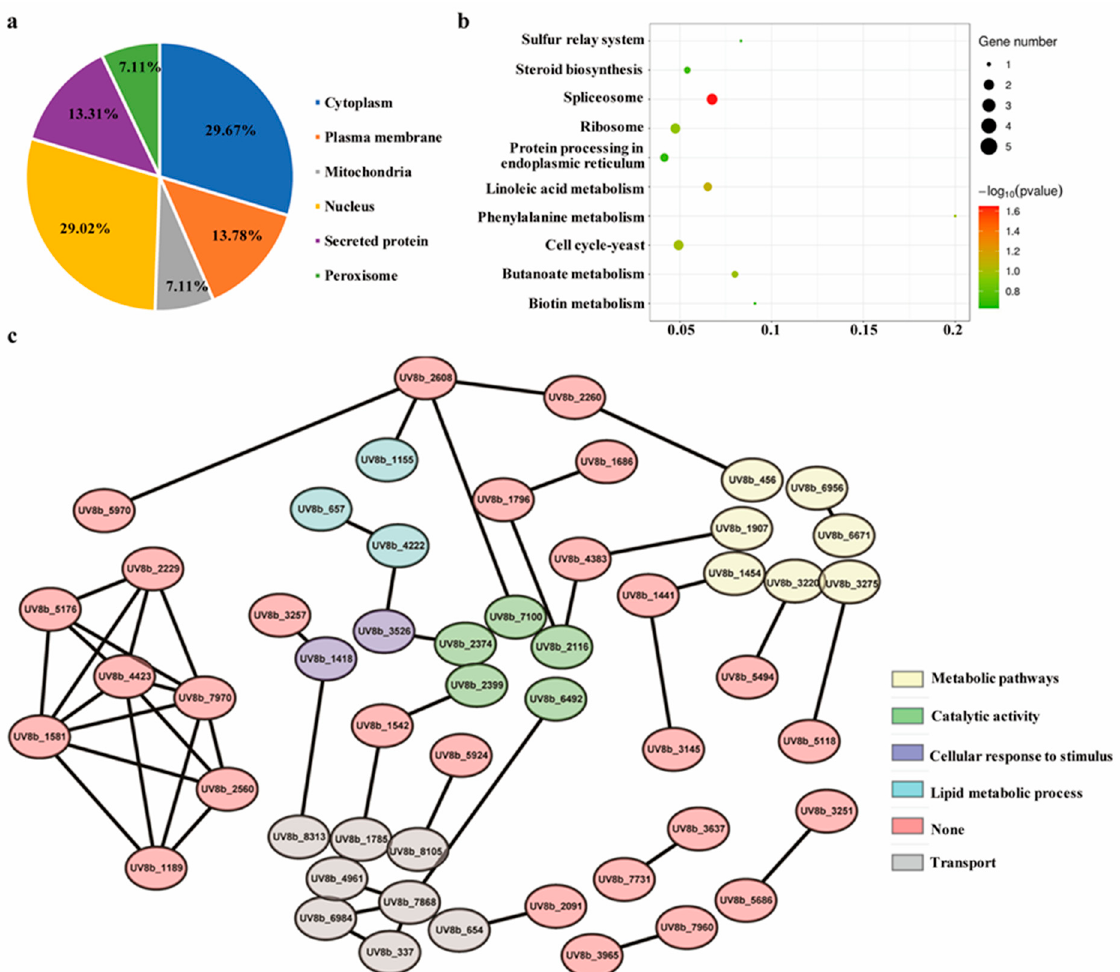
Figure 7. Prediction of subcellular localization, protein–protein interaction (PPI) map and functional annotation of differentially accumulating proteins (DAPs). ( a ) Predicted subcellular localizations of DAPs. ( b ) KEGG pathway analysis of DAPs. ( c ) Protein–protein interaction (PPI) network of DAPs.